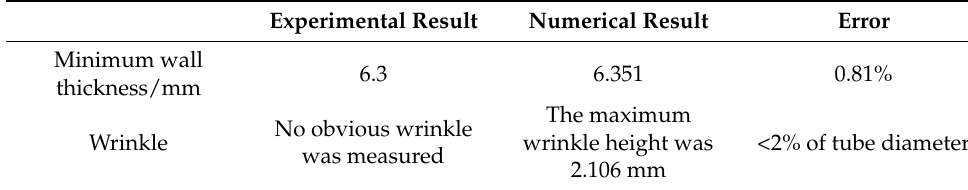
Table 4. Experimental and numerical results of